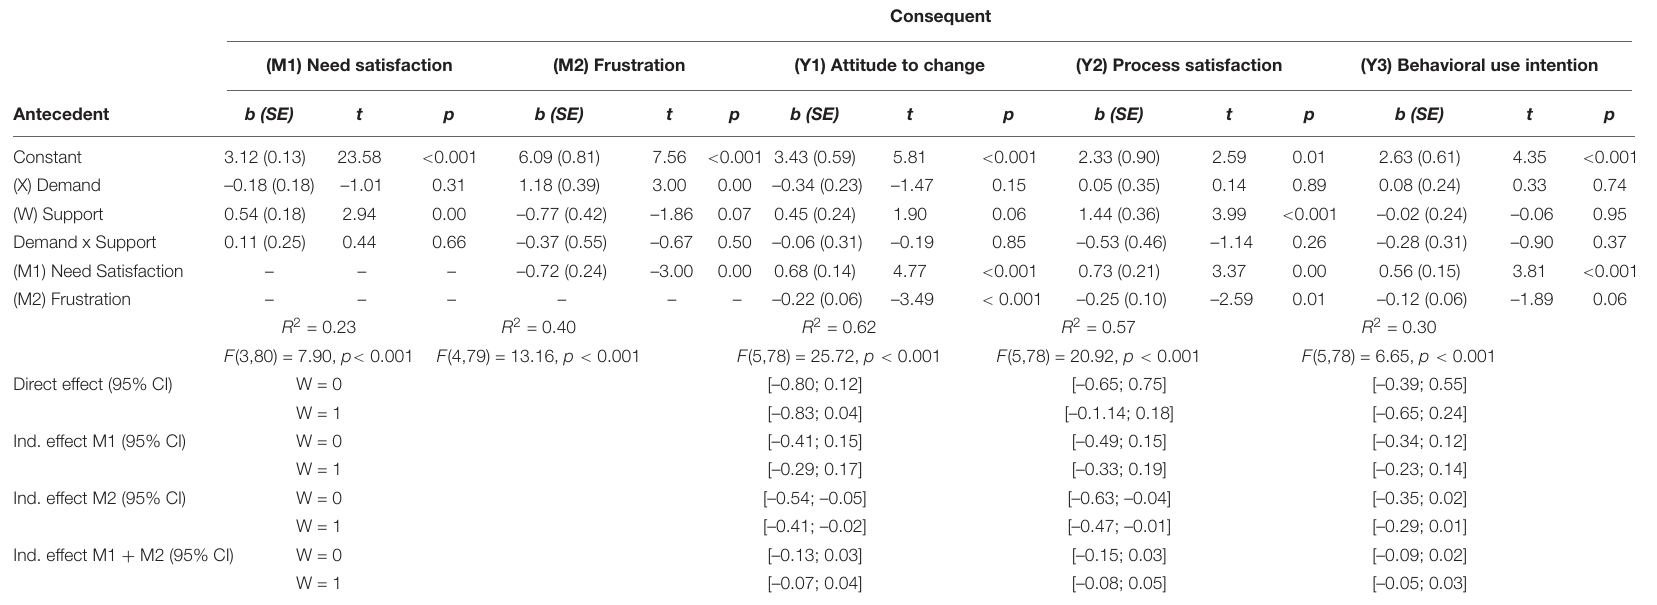
TABLE 4 | Regression coefficients, standard errors, and model summary information of the moderated mediation model – Study